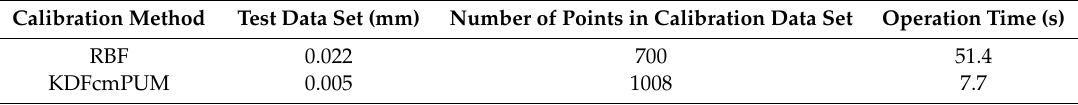
Table 5. Comparison with di ff erent calibration